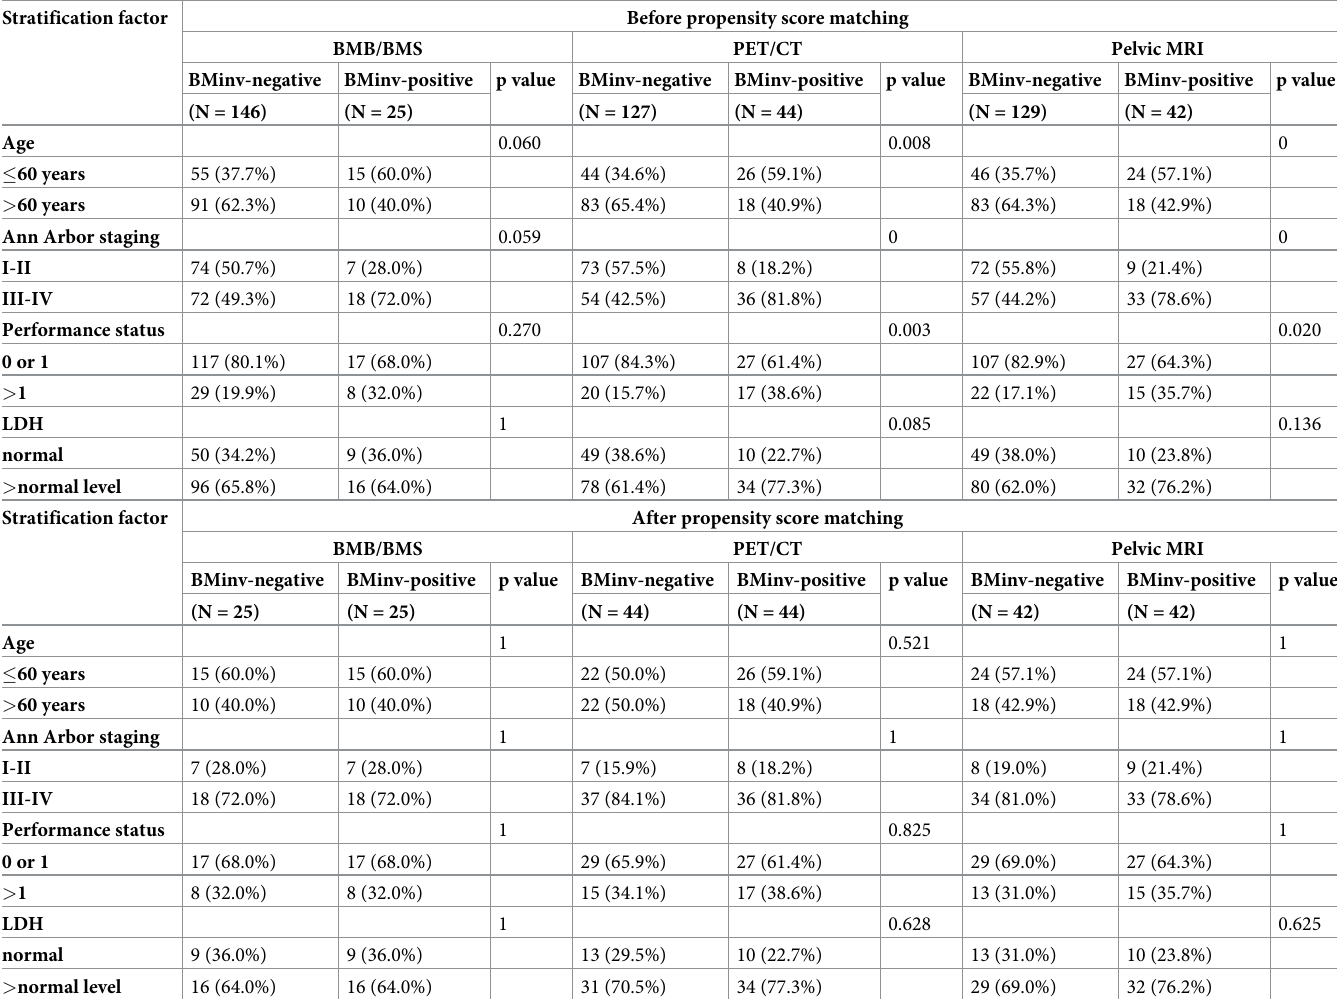
Table 7. Patient characteristics for different groups before and after propensity score